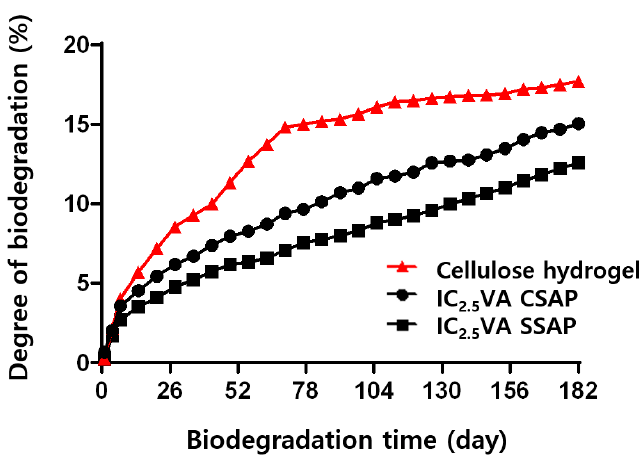
Figure 5. Degree of biodegradation of IC 2.5 VA CSAP and SSAP.